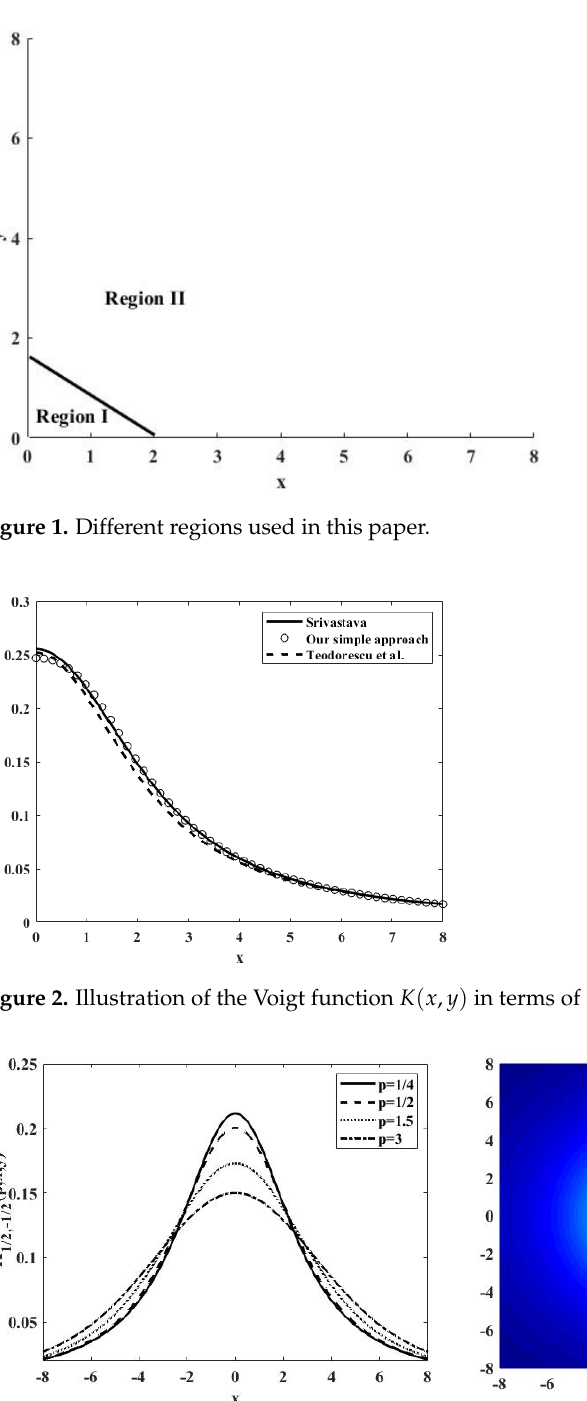
Figure 3. The generalized Voigt function K 1/2, − 1/2 ( p , x , y ) distribution versus x with ( a ) different values of p and ( b ) contour graph for p = 1 4 .